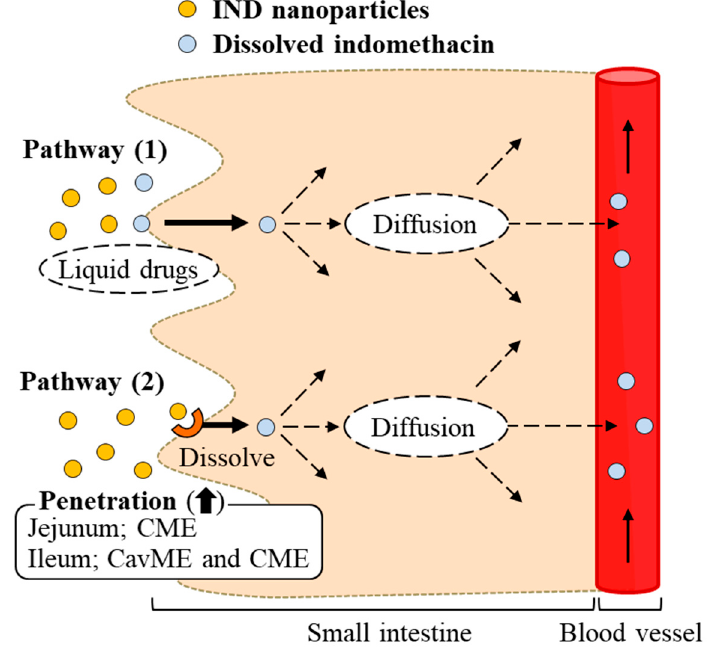
Figure 7. Scheme for intestinal absorption following the oral administration of IND-NPs formulation.